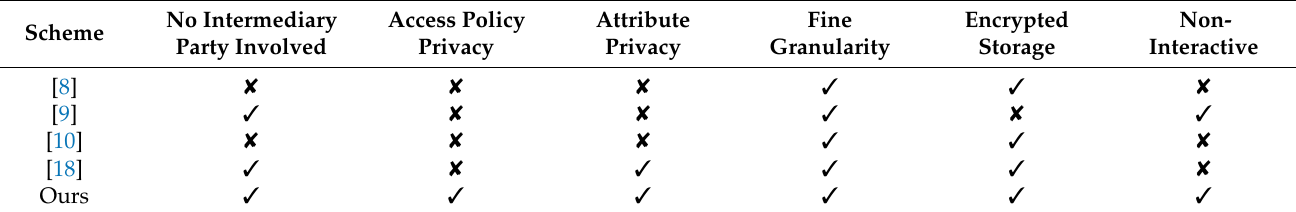
Table 1. Comparisons with previous